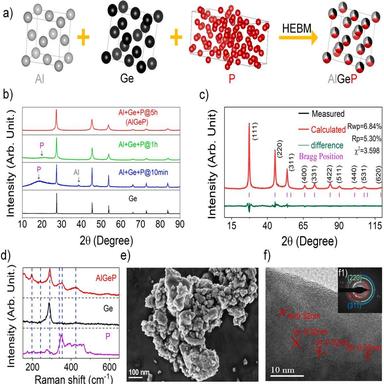
(a) Schematic illustration of process for synthesizing AlGeP solid solution, (b) XRD patterns of Ge and various Al+Ge+P samples of Al+Ge+P @ x h, where x means milled for x h, x = 1/6, 1, and 5 h), (c) refined XRD pattern of synthesized AlGeP solid solution, (d) Raman spectra of as-obtained AlGeP solid solution and milled P and Ge powders, (e) lowmagnitude FESEM image of AlGeP solid solution, and (e) HRTEM image and SAED pattern (inset) of AlGeP solid solution.